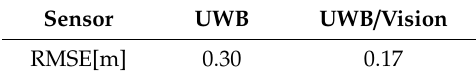
Table 4. RMSE values of the positioning accuracy of UWB alone and UWB / Vision. Table 3. Root mean square error (RMSE) values of the positioning accuracy of UWB alone and UWB/Vision.